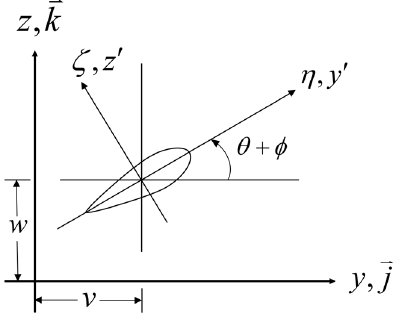
Figure 2. Definition of blade cross-section coordinate. For the convenience of numerical calculation, the blade was divided into a finite number of elements, and the displacement at any point of the blade is expressed in terms of generalized displacements at element nodes by appropriately selecting displacement shape functions. In this way, the strain energy of the blade can be expressed in terms of generalized displacements at element nodes, and the line integral operation along the entire blade can be transformed into discrete multiply–add operations by the Gaussian integral at element nodes.